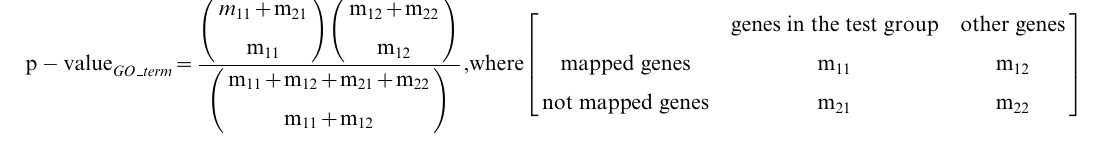
Figure S1 P-value distribution for miRNAs detected in the rat hippocampus by deep-sequencing. (A) Representative gel image of miRNA deep-sequencing libraries. (B) Frequency histogram of p-values for miRNAs analyzed at 24 hours post-CCI. (C) Frequency histogram of p-values for miRNAs analyzed at 7 days post-CCI. Table S1 RIN and summary of deep-sequencing reads. The RIN, numbers of obtained sequence reads and mapped reads for each sample are listed. Conditional Hypergeometric test of a GO term annotating the over (cid:2) represented